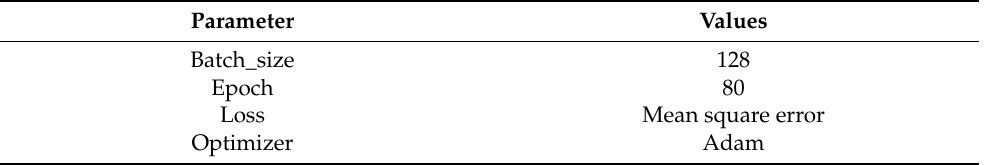
Table 2. Parameter settings for the autoencoder algorithm.